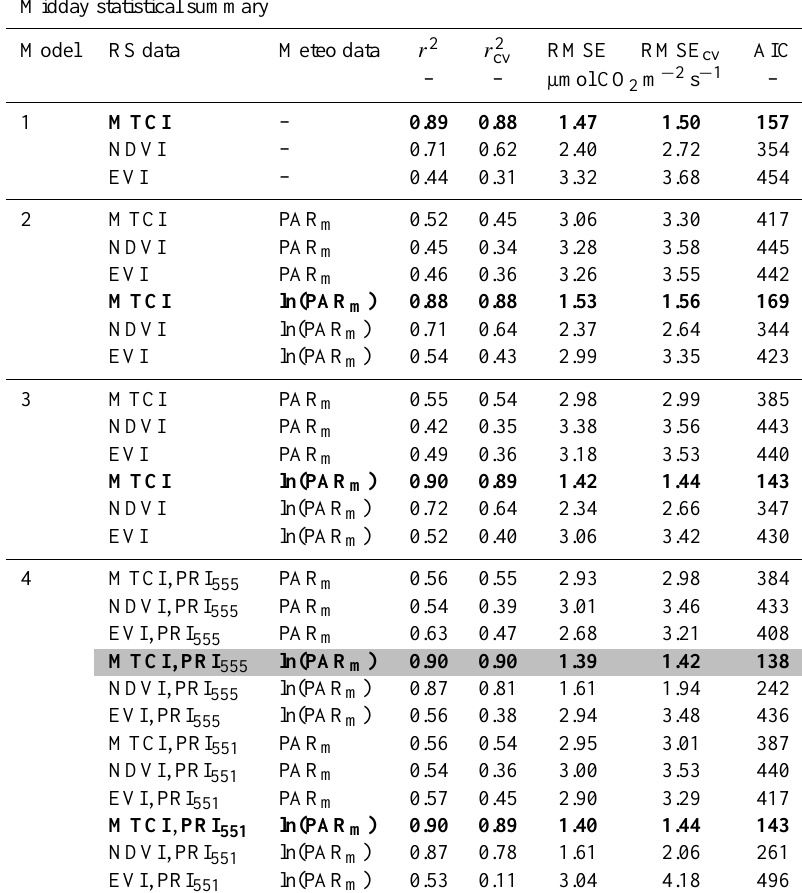
Table 3. Summary of statistics in fitting ( r 2 and RMSE) and cross-validation ( r 2 cv , RMSE cv and AIC) of different models tested in this study using average GPP m and PAR m data. The best-performing models in each class are in bold print. The most successful of all models is grey